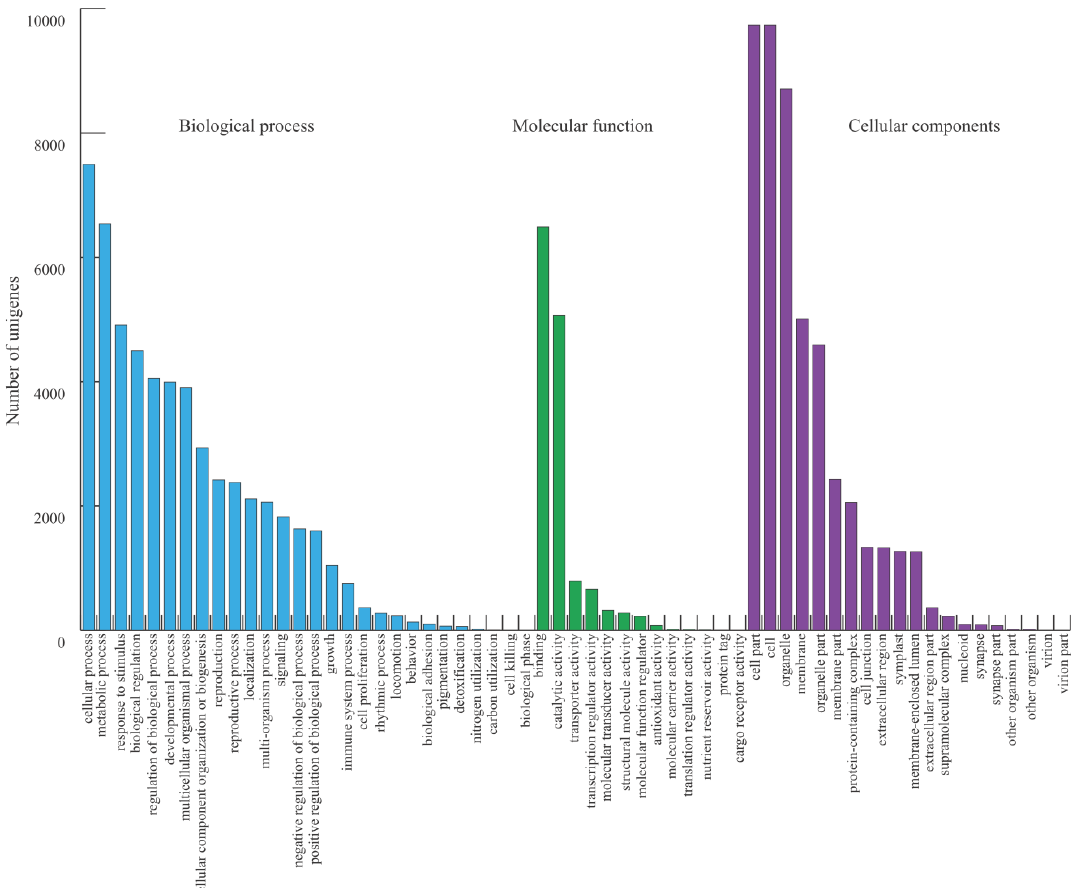
Figure 2. Enrichment analysis of the gene ontology terms assigned to the final set of kenaf unigenes. The unigenes with assigned GO terms were compared against the Kyoto encyclopedia of genes and genomes (KEGG) database for pathway analysis. In total, 8875 kenaf unigenes were assigned to 149 KEGG pathways and given 813 EC numbers that were used to represent putatively identified genes involved in various pathways. The annotated unigenes were grouped into five major categories (Figure 3A), “metabolism” (8453 unigenes), “ organismal system” (264 unigenes), “environmental information processing” (98 unigenes), “genetic information processing” (59 unigenes), and “human disease” (1isoform). Under “metabolism , ” the highest number of unigenes were mapped to “carbohydrate metabolism” (1512 unigenes) followed by " nucleotide metabolism” (1311 unigenes), “amino acid metabolism” (1055 unigenes), “metabolism of cofactors and vitamins” (952 unigenes), and “lipid metabolism” (812 unigenes) (Fig ure 3B). Details of the KEGG analysis, including information for pathways, enzymes in pathways, enzyme annotation, sequences, and categories and subcategories are provided in Table S4. These annotations will provide a valuable resource for further gene function and pathway research.